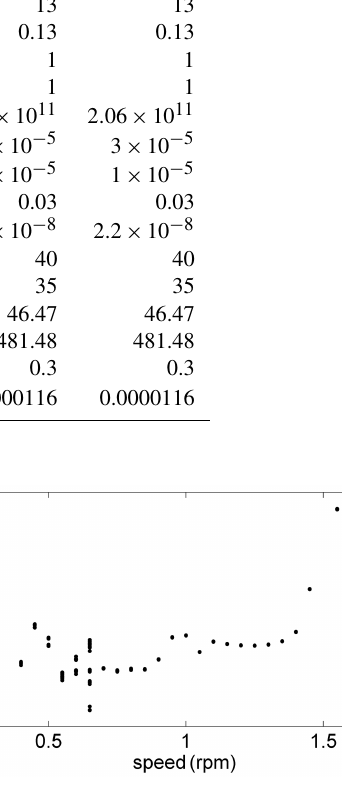
Figure 6. Bifurcation at the torque load of 5000Nm and the lubri- cating oil viscosity of